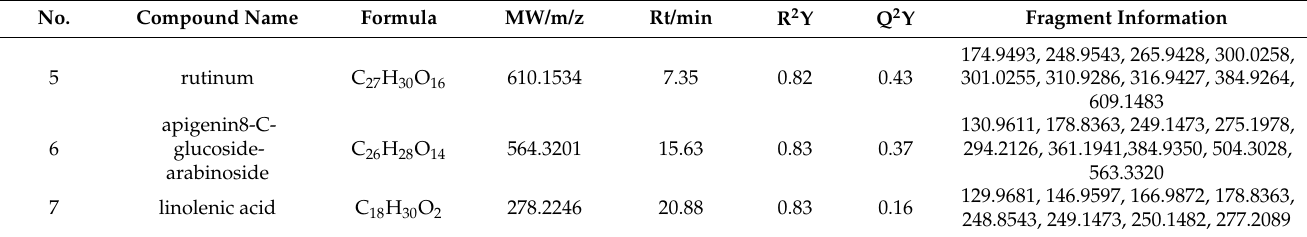
PCA score table, and the chemical composition relationship associated with the in fl am- matory factor IL-1 β in the LPS-induced in fl ammation model was obtained. Based on PLS modeling analysis, seven relevant principal components were obtained: chlorogenic acid